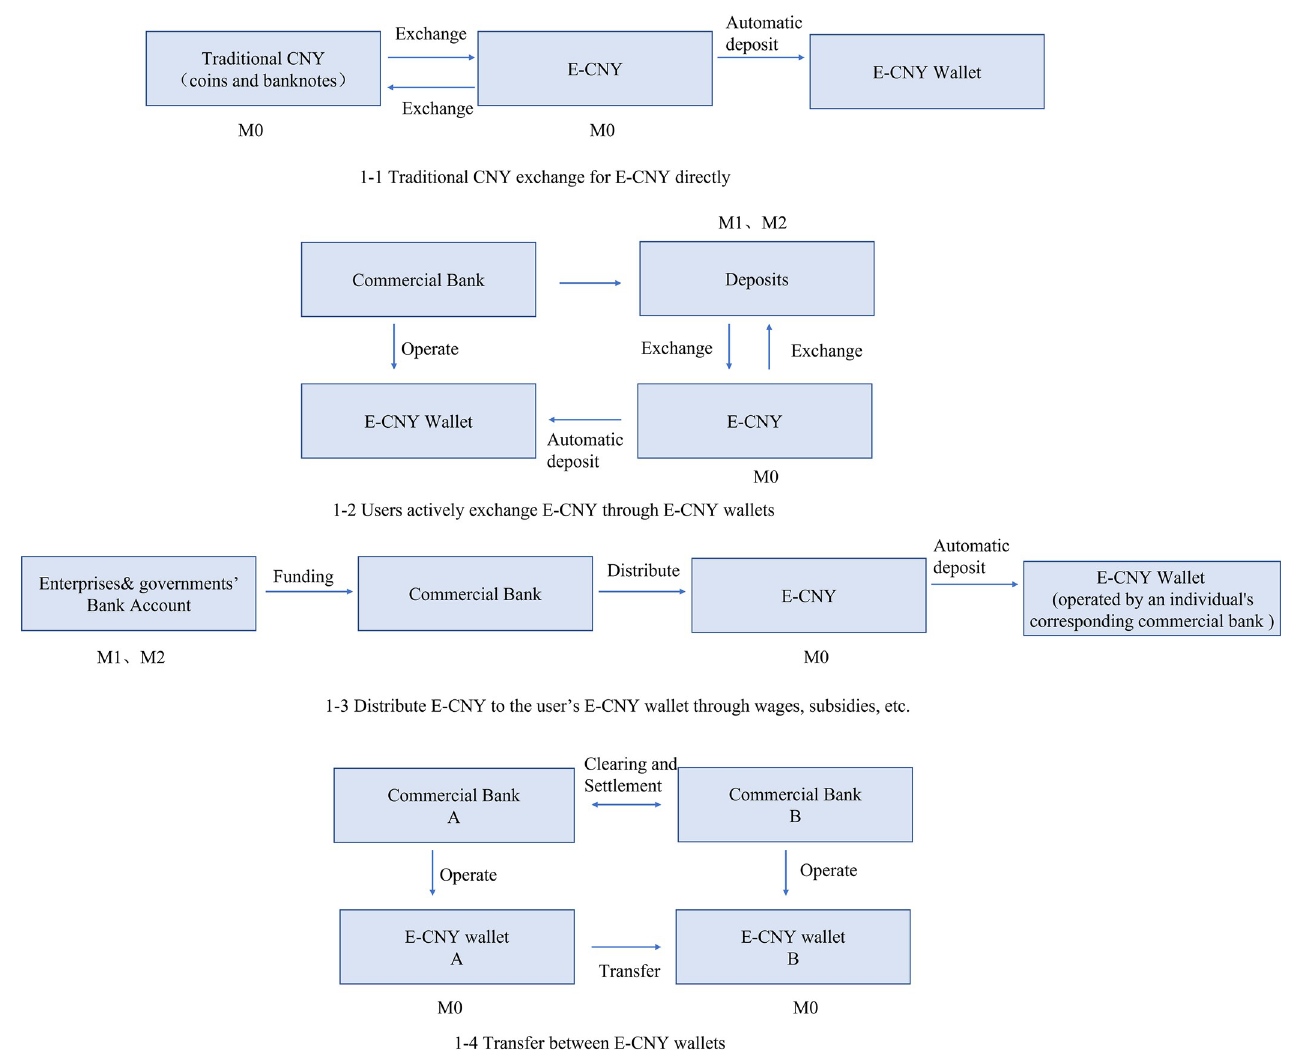
Fig 1. Four issuing and exchanging channels of